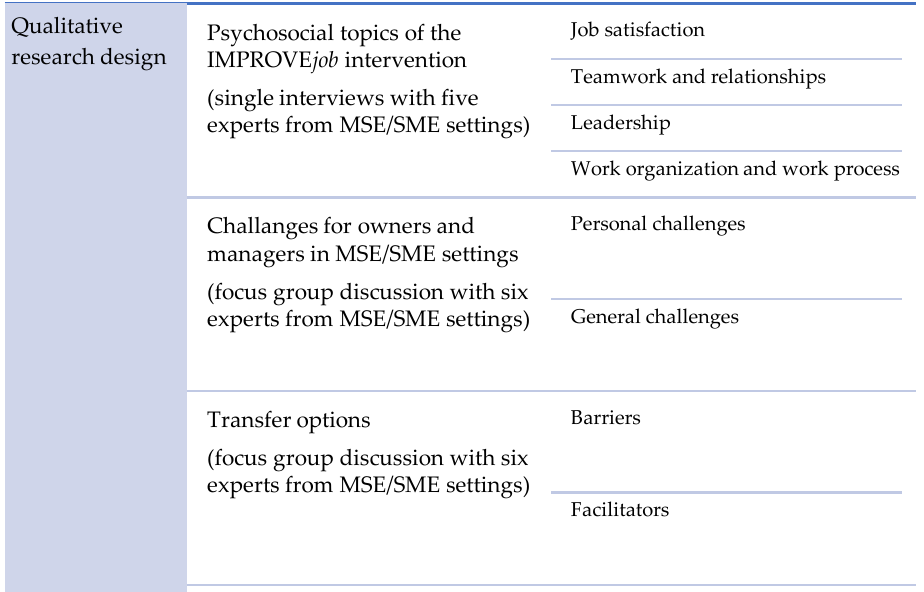
Figure 1. Overview of the results of the single interviews and the focus group discussion.